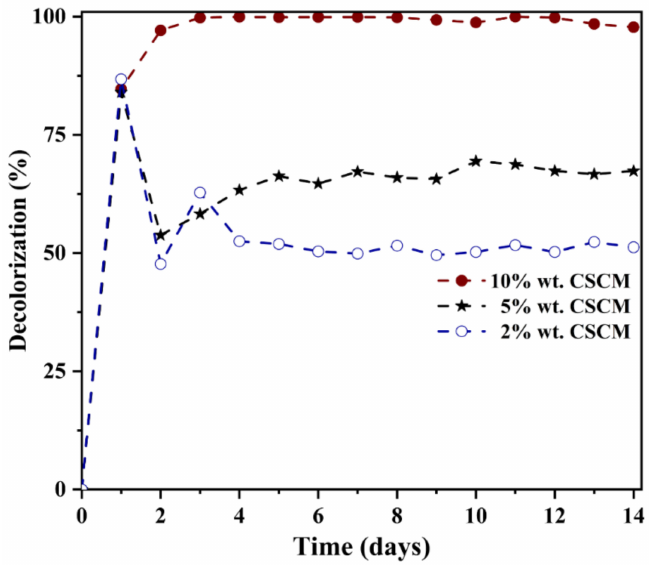
Figure 6. Influence of precursor concentration on anaerobic bioreduction of AO7; Flux